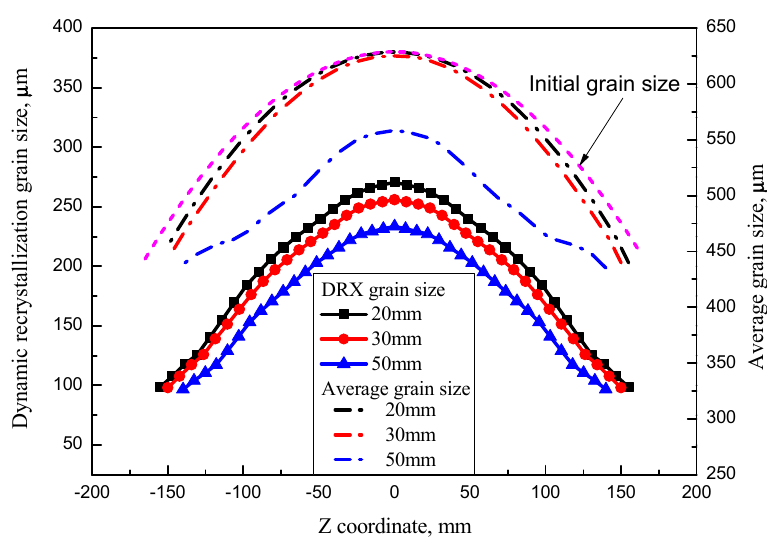
Figure 16. The DRX grain size and average grain size variation with the thickness of the slab.